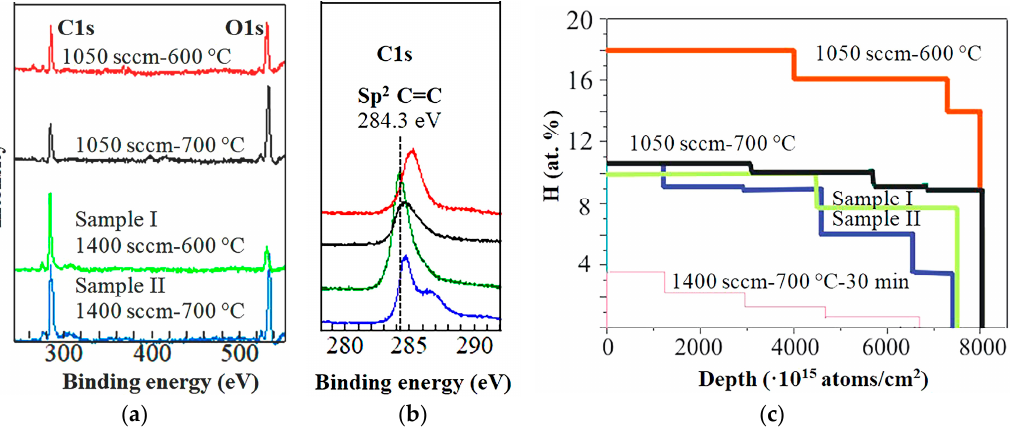
Figure 5. ( a , b ) The XPS spectra and (c) the ERDA measurements for the CNWs grown at 1050 sccm − 600 °C − 60 min (red line), 1050 sccm − 700 °C − 60 min (black line), 1400 sccm − 600 °C − 60 min (green line) and 1400 sccm − 700 °C − 60 min (blue line). The figure includes in ( a ) the C1s and O1s bands, ( b ) the amplification of the C1s band and ( c ) the hydrogen content along the transversal section (depth) of the samples, including 1400 sccm − 700 °C − 30 min (purple line).